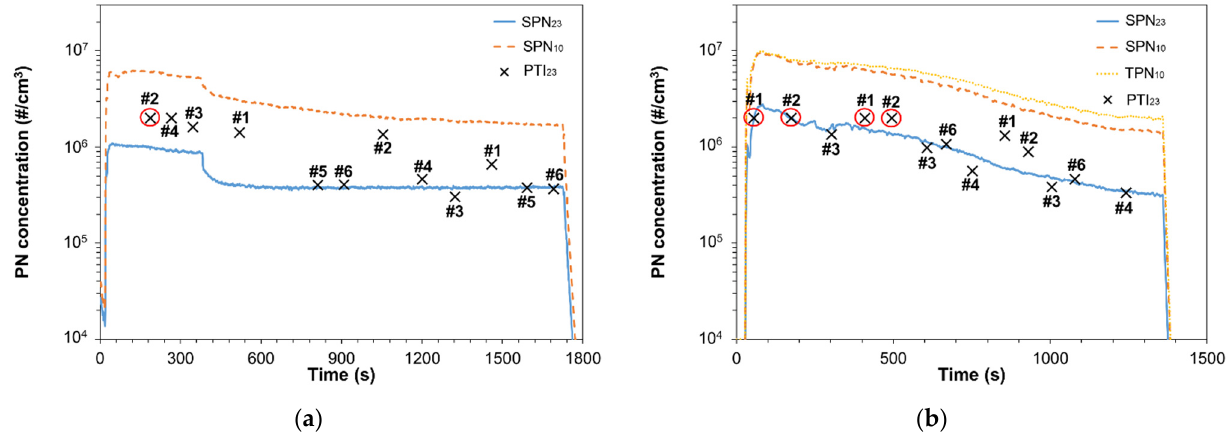
Figure 3. Particle number concentration during low idling with cold start engine for: ( a ) Euro 4 diesel V3; ( b ) Euro 6d with DPF bypass V4. Points in red circle show that the PTI sensors reported a threshold concentration that corresponds in automatic failure (2 × 10 6 #/cm 3 for NL or 5 × 10 5 #/cm 3 for DE).